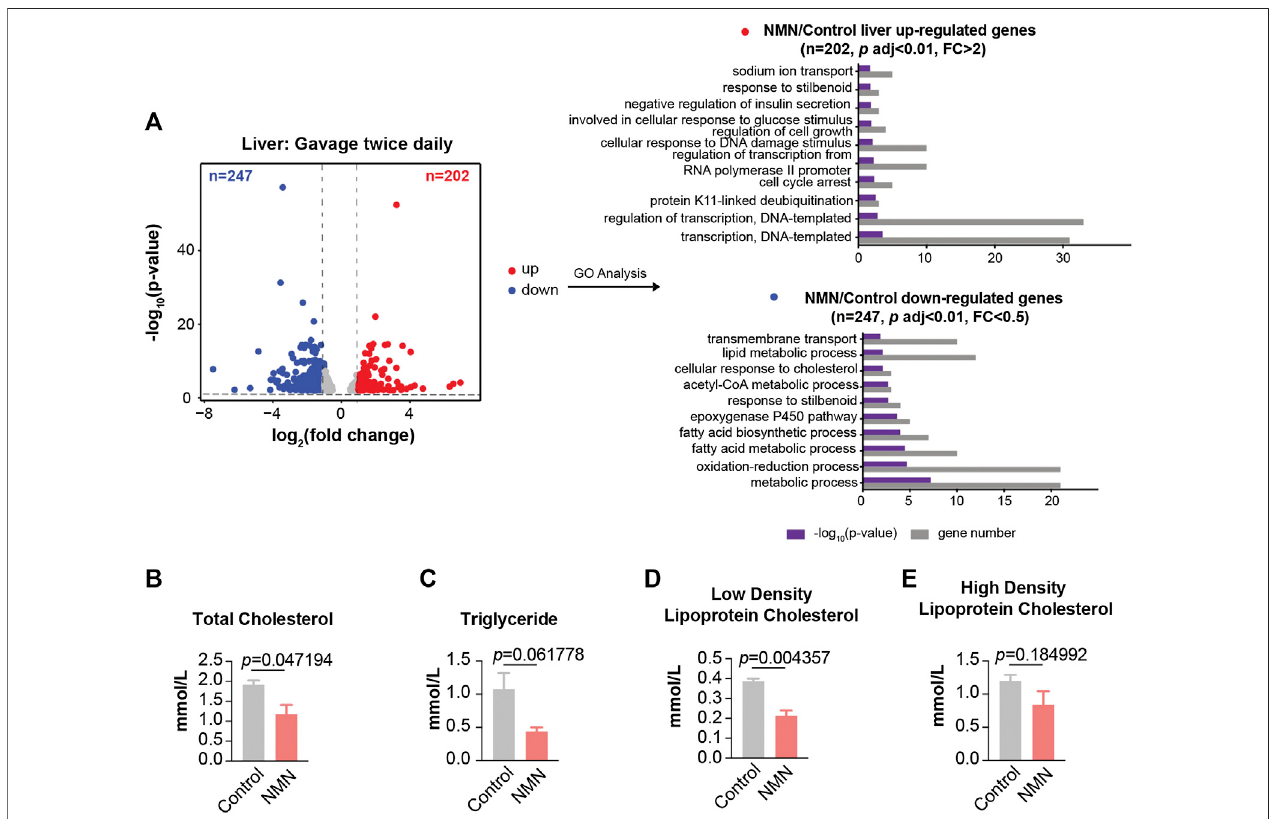
FIGURE 5 | Transcriptomic Analysis in 2680 mg/kg/d NMN-Administrated Mice Liver (A) Volcano plot shows that genes are differentially expressed in 2680 mg/kg/d NMN-administrated mice compared to control in liver (left panel) . Differential expression analysis was performed by DESeq2 from three biological replicates. 202 genes were found to be upregulated ( p < 0.01, FC > 2), 247 genes were down regulated ( p < 0.01, FC < 0.5). Gene ontology (GO) analysis were performed by David (right panel) . The result shows lipid metabolic process being the biological processes signi fi cantly enriched for genes down regulated in 2680 mg/kg/d NMN administration group. The bar graphs represent – log10 ( p value) and gene counts in each pathway. (B – E) Blood lipids were measured after 2680 mg/kg/d NMN administration. (B) Total Cholesterol was decreased in 2680 mg/kg/d NMN-administered mice. (D) Low density lipoprotein cholesterol was decreased in 2680 mg/kg/d NMN-administered